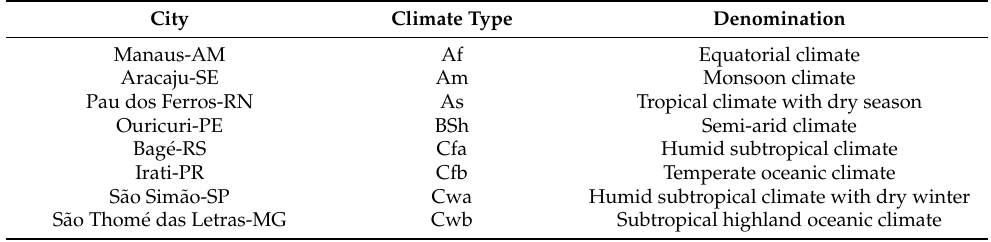
Table 1. Climate types of the analyzed cities according to the Köppen–Geiger climate classification.